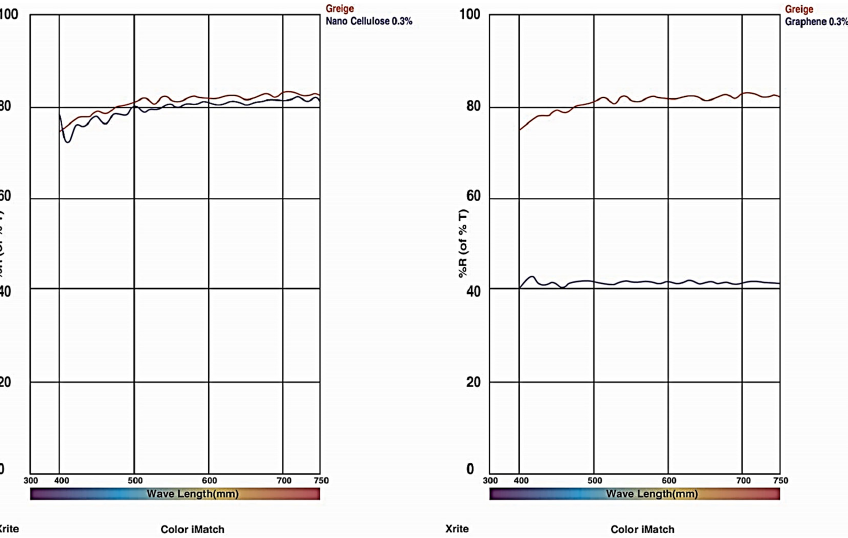
Figure 10. Schematic presentation of the nano wavelength distribution of (CNC and graphene) nanofluids.